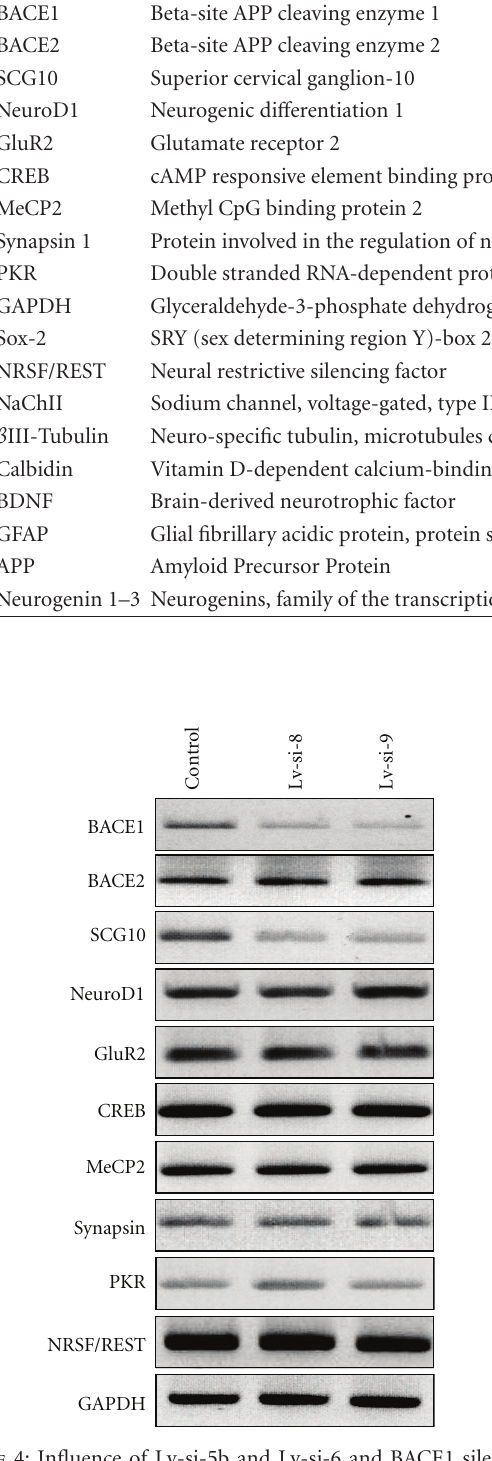
Figure 4: Influence of Lv-si-5b and Lv-si-6 and BACE1 silencing on expression of selected genes in HCN A94 cells, as determined by